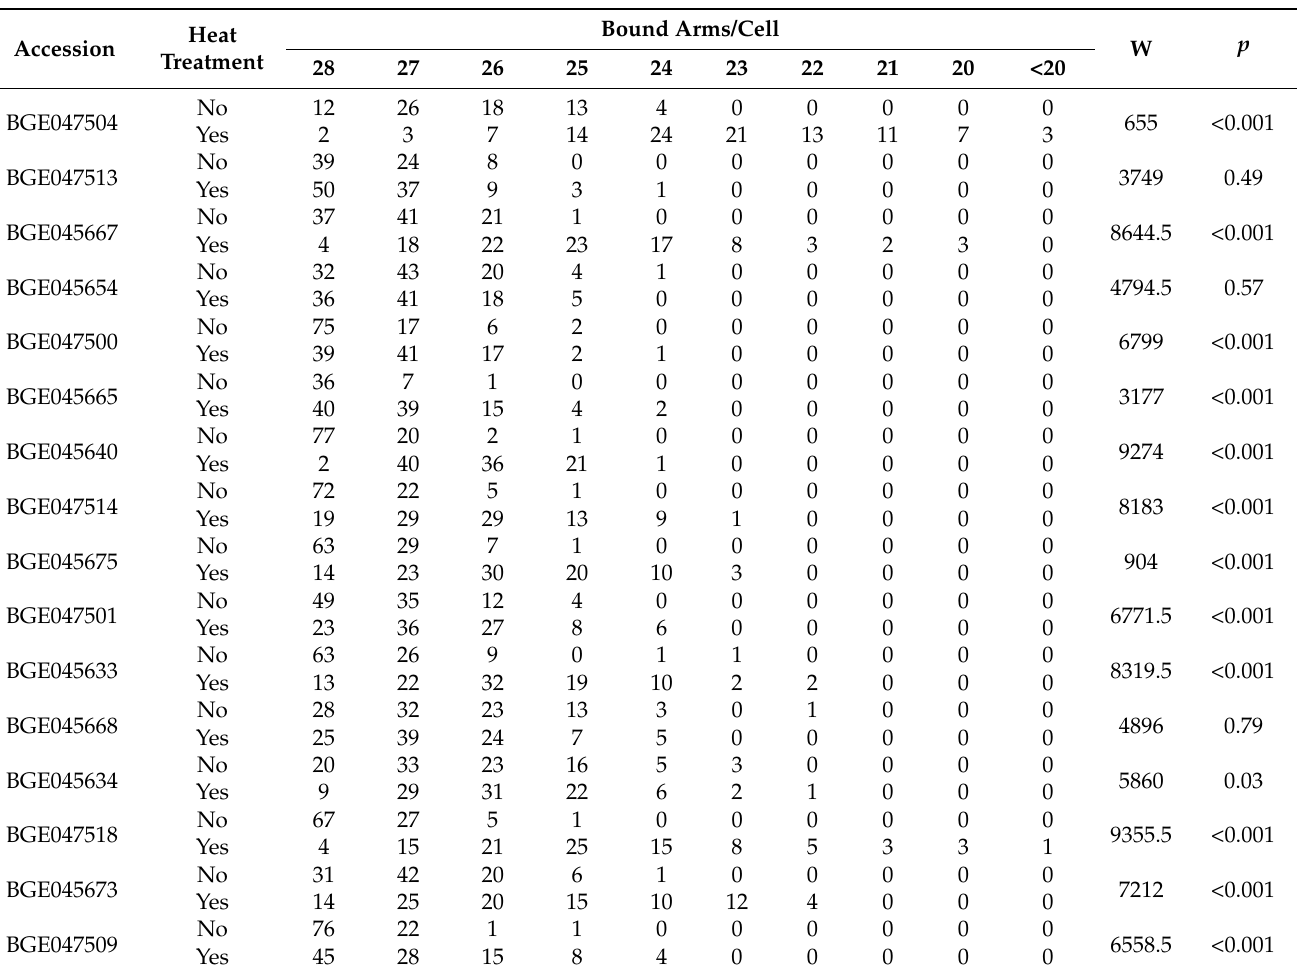
Table 3. The number of bound arms per cell in plants of Spanish landraces of T. turgidum subjected or not at heat temperature during premeiosis and meiosis are compared using Mann-Whitney- Wilcoxon